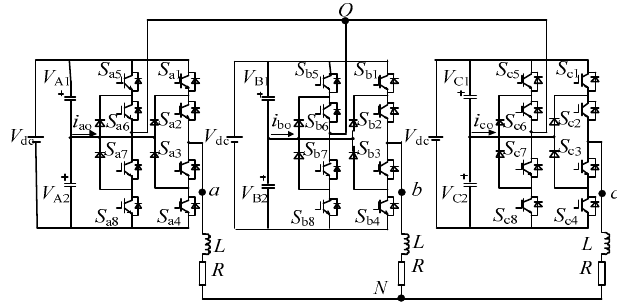
Figure 1. A diagram of a five-level, neutral-point-clamped (NPC)/H-bridge inverter’s main circuit.